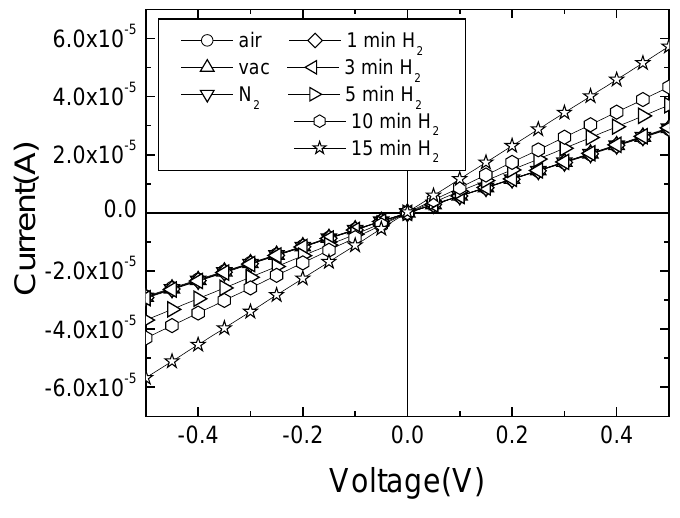
Figure 16 . I-V characteristics of Pt-coated ZnO single nanorods measured in vacuum, air, N or 500ppm H in N ambients. The latter responses were time-dependent. 2 2 2